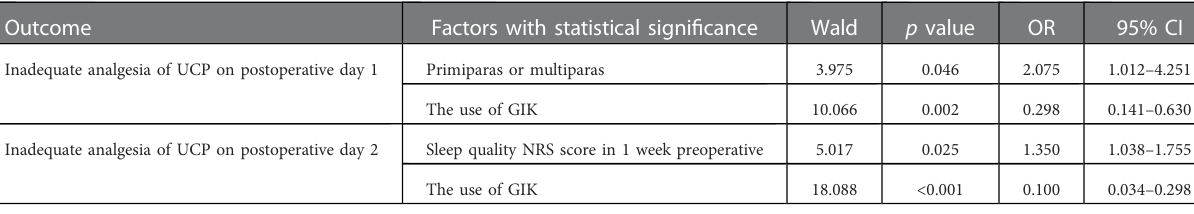
TABLE 2 Factors associated with inadequate analgesia in a stepwise logistic regression analysis. Outcome